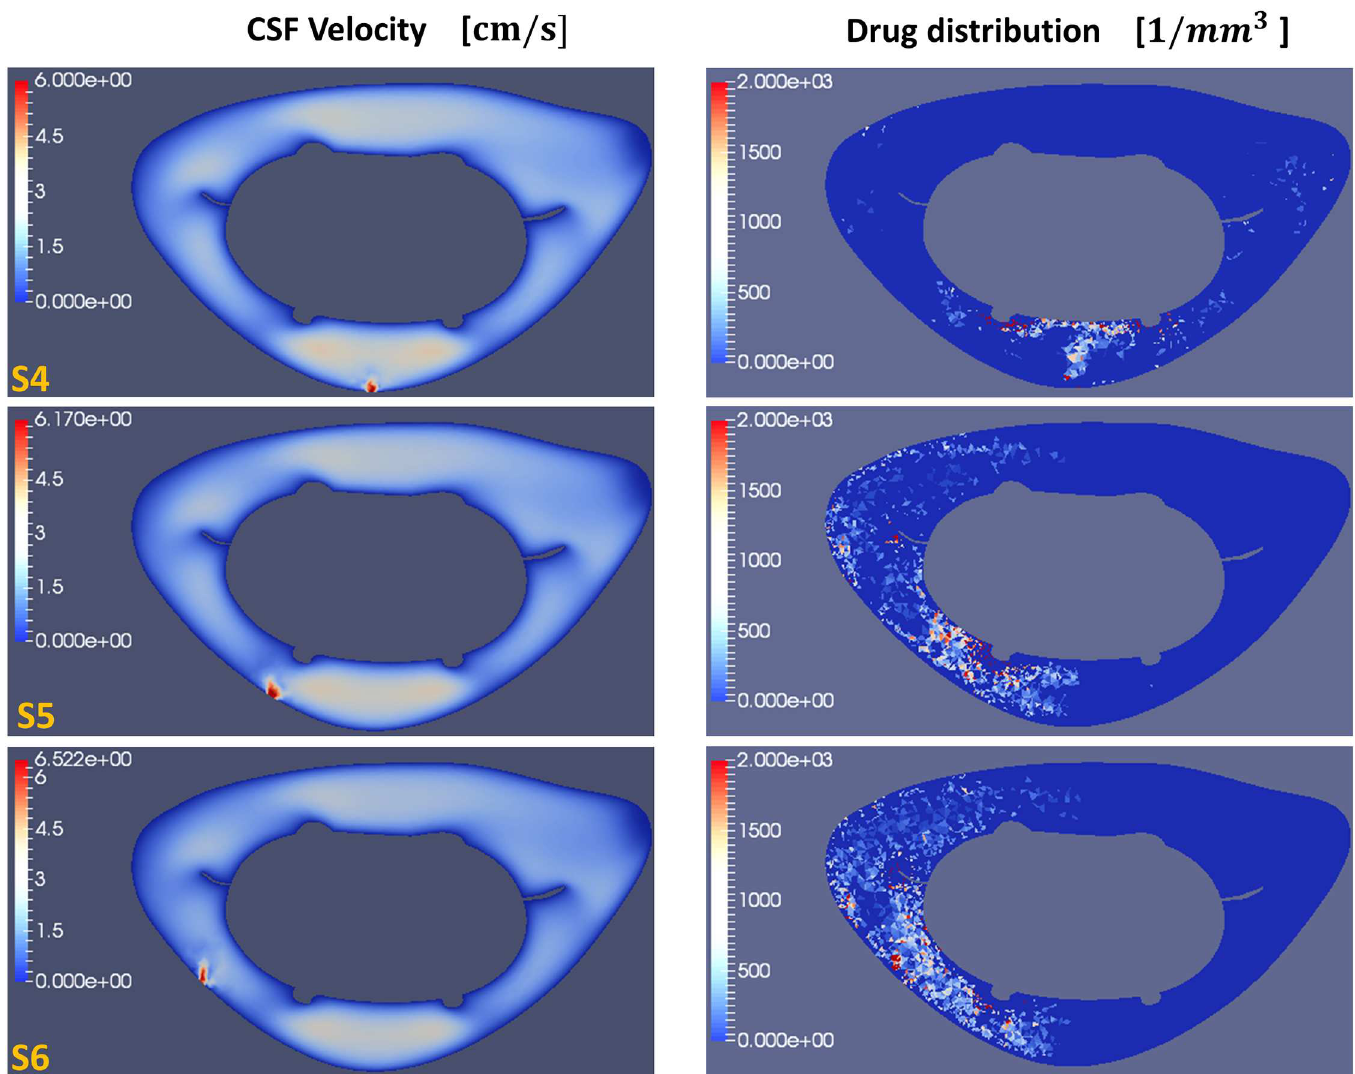
Fig 8. Cross-sectional views of the CSF velocity magnitude and dimensional drug concentration. (left) Magnitudeof the CSF velocity at t = 20 T and (right) correspondingdimensional drug concentration (number of particles per volume)at Δ y = 0 cm (C5-level)for test cases S 4 , S 5 and S 6 .